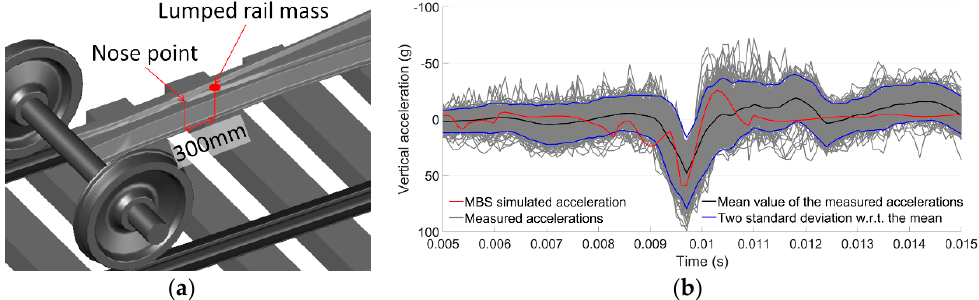
Figure 19. MBS model validation: ( a ) rail element for acceleration extraction; ( b ) comparison of MBS simulated acceleration with the measured ones in a time domain.